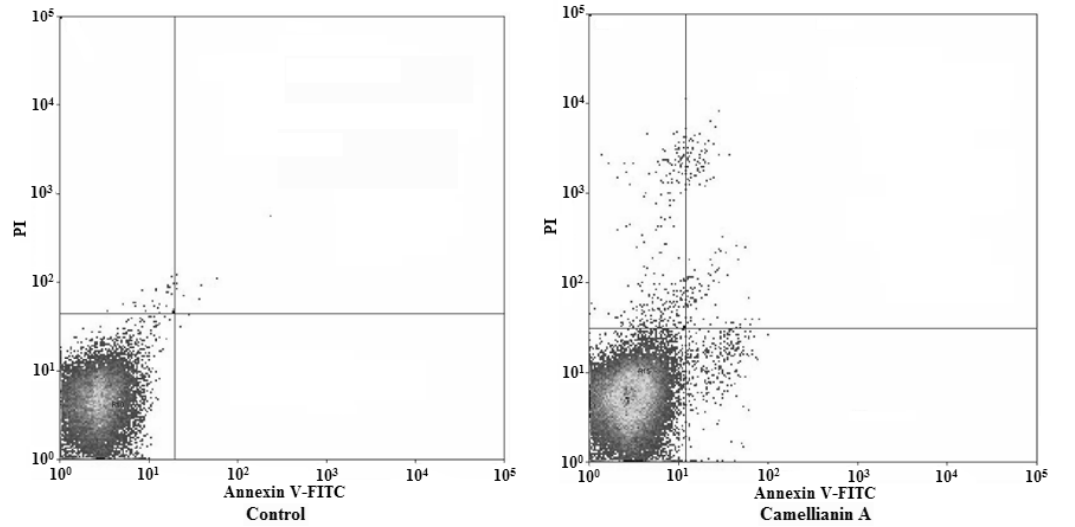
Figure 8. Flow cytometric analysis of phosphatidylserine externalization and cell membrane integrity in MCF-7 cells undergoing